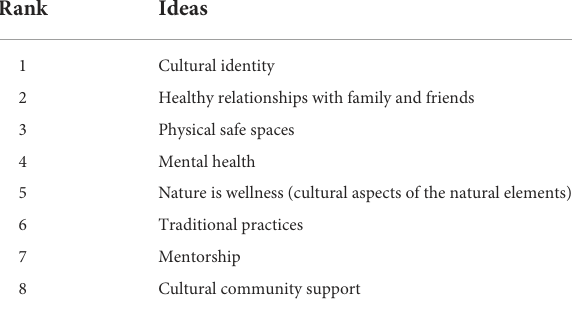
TABLE 1 Nominal group technique top eight